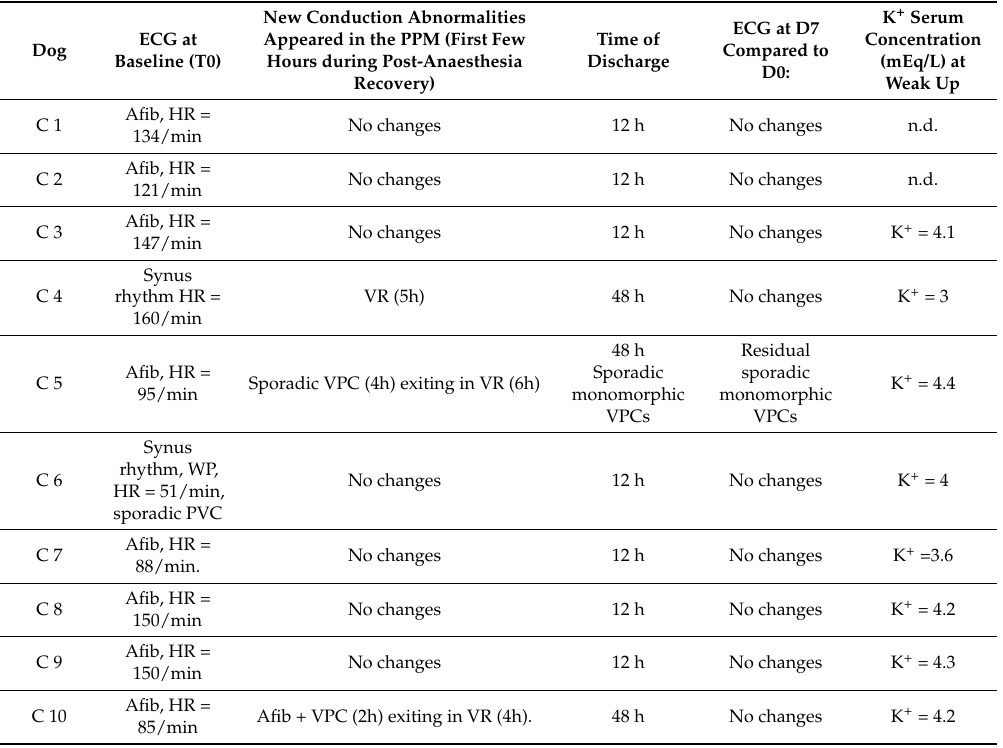
Table 2. New conduction abnormalities appearing in the post-procedure monitoring in the 10 dogs after intracoronary cytoprotective gene therapy. ECG abnormalities at baseline, presence of new abnormalities (compared with baseline) at post-procedure monitoring and at D7 are reported. Furthermore, the time of discharge and the potassium serum concentration at the time of weak up after anaesthesia is reported.